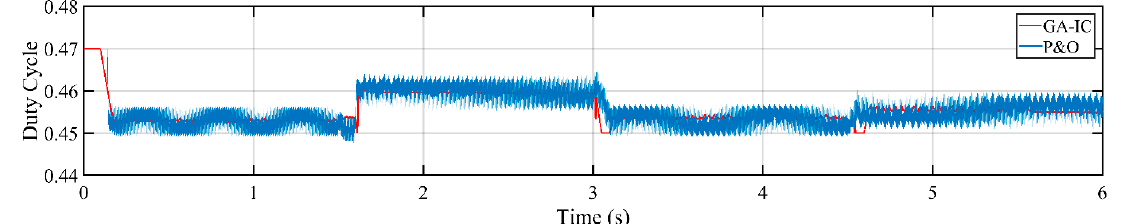
Figure 14. Case 1 duty cycle comparison.